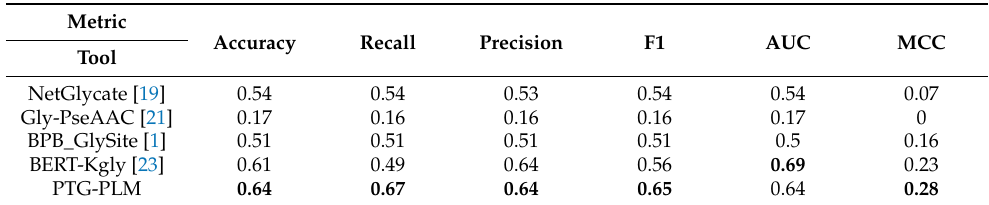
Table 10. Comparison of the performance of PTG-PLM against the existing tool for Kgly site prediction.